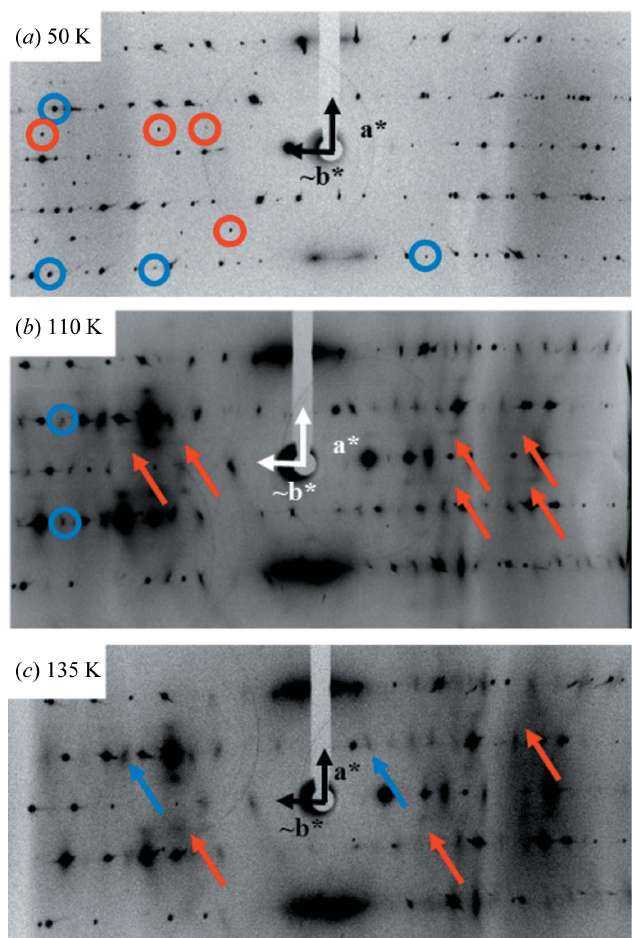
Figure 6 Typical X-ray patterns taken in the three phases. ( a ) At 50 K, for this X-ray pattern the (cid:4) /2 contribution has been suppressed. The red circles indicate the ( 1 0 0) satellite reflections and the blue circles indicate the 2 1 (0 1 ) satellite reflections. ( b ) At 110 K, the red arrows indicate the 2 2 diffuse lines associated with the regime of quasi-one-dimensional fluctuations of the SP transition and the blue circles indicate the (0 1 satellite reflections. ( c ) At 135 K, the red arrows indicate the diffuse lines associated with the regime of quasi-one-dimensional fluctuations of the SP transition and the blue arrows show the isotropic regime of fluctuation associated with the anion